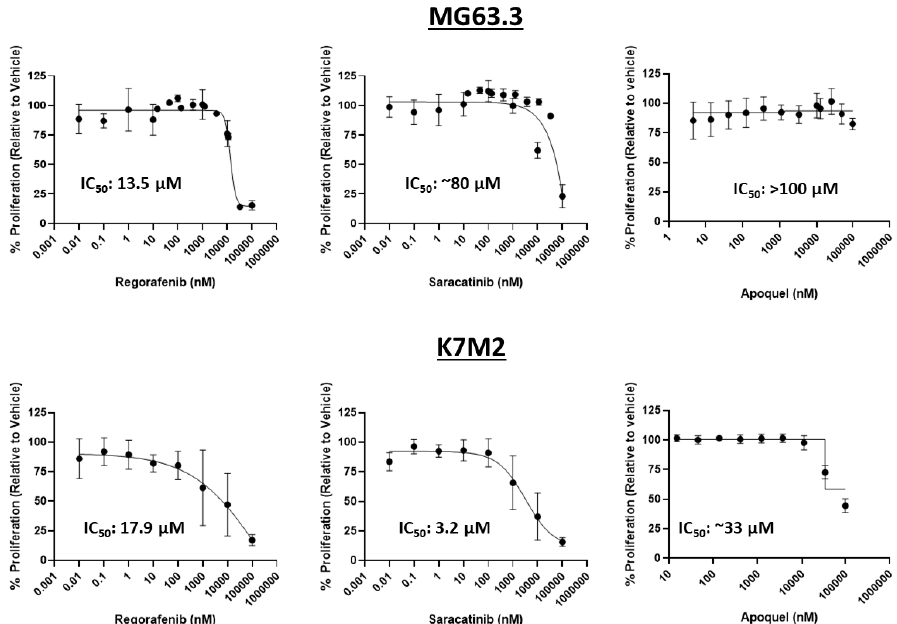
Figure 2. Drug exposures at or below 1 µ M were determined to be non-cytotoxic in highly metastatic OS cells. The inhibition of OS cell number in 2D culture was measured in dose-response via MTT assay. Regorafenib, saracatinib, and oclacitinib were tested at various doses (10 pM-100 µ M) in MG63.3 (top) and K7M2 (bottom) for 72 h. IC50s were calculated using a four-parameter variable slope nonlinear fit in GraphPad Prism. (N = 3, replicates = 3 – 9).